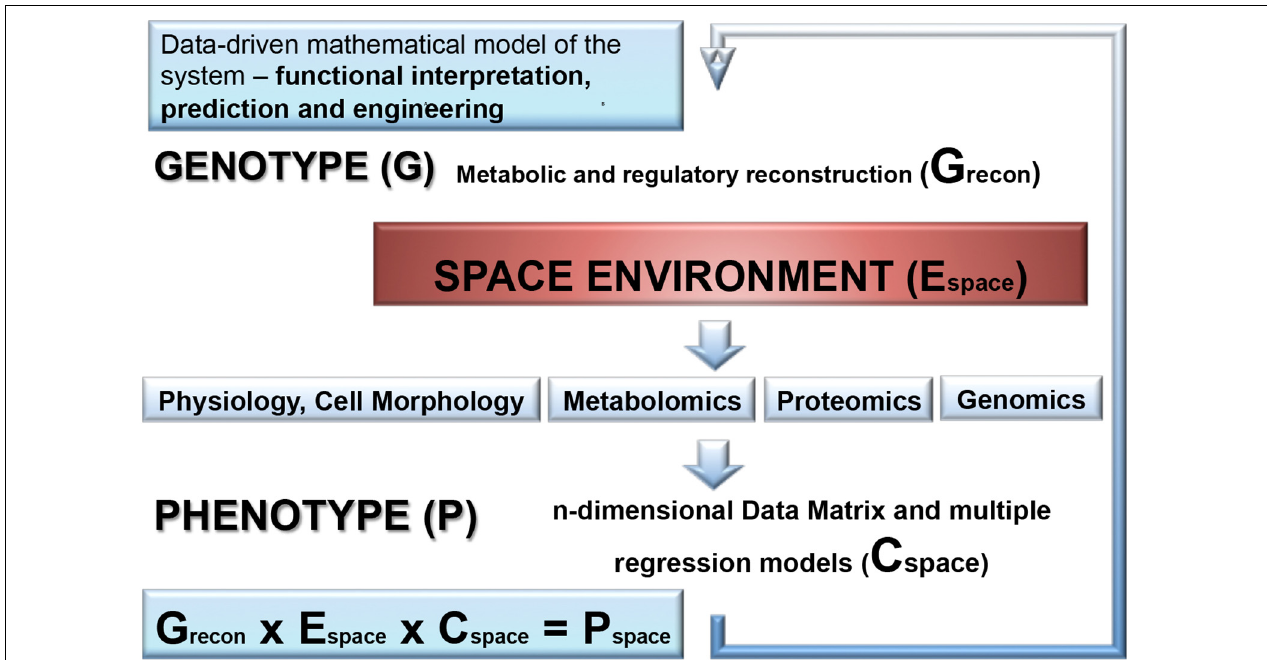
FIGURE 5 | A combination of molecular data with a genome-scale metabolic reconstruction of the microbial species exposed to the space environment. First, genome-scale metabolic and regulatory reconstruction of the respective microorganism is performed based on the available genome sequence and gene annotation information and results into a genotype matrix (G recon ). This provides the basic predictive metabolic model to eventually integrate statistical models of molecular data generated by OMICS technology, physiological and morphological data as well as environmental parameter which are accurately monitored in outer space conditions. The molecular and physio-morphometric data are correlated with environmental parameter by multiple regression methods and generate a comprehensive data covariance matrix times environmental data matrix (C space × E space ). The resulting data covariance model is eventually connected with the genotype matrix G recon to generate a biomathematical data-driven regulatory and predictive model for the response trajectory of the microorganism in outer space conditions (P space ). Overall, this is an iterative process improving step by step the predictive models (for further information see Weckwerth et al., 2004; Weckwerth and Morgenthal, 2005; Weckwerth, 2011a, 2016, 2019; Sun and Weckwerth, 2012; Doerfler et al., 2013; Nägele et al., 2014, 2016; Sun et al., 2015).